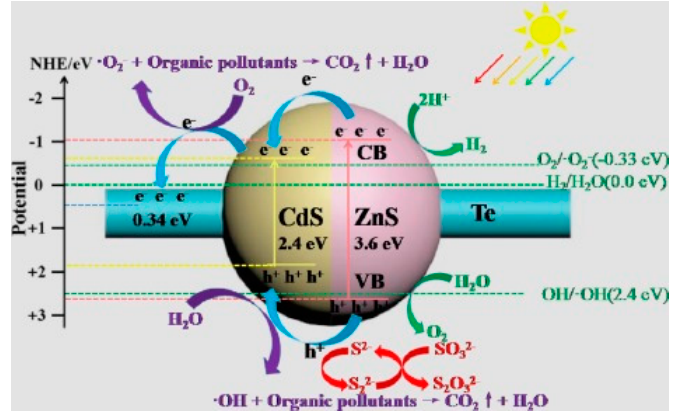
Figure 2. Possible mechanism of ZnS@CdS-Te composite photocatalysts. Figure adapted from Figure 2. PossiblemechanismofZnS@CdS-Tecompositephotocatalysts. Figureadaptedfromreference[35]. reference [35]. Table 4. Photocatalytic H 2 generation performances of ZnS-based photocatalysts